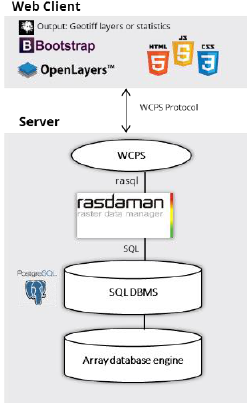
Figure 3. Social media data management with RASDAMAN